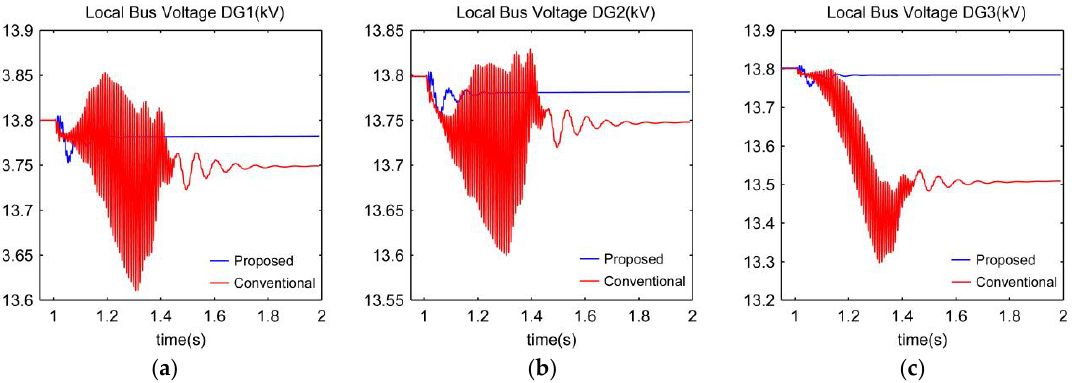
Figure 14. Voltage response of DG’s during islanding using proposed supplementary control compare with conventional droop controller ( a ) DG1; ( b ) DG2; and ( c )